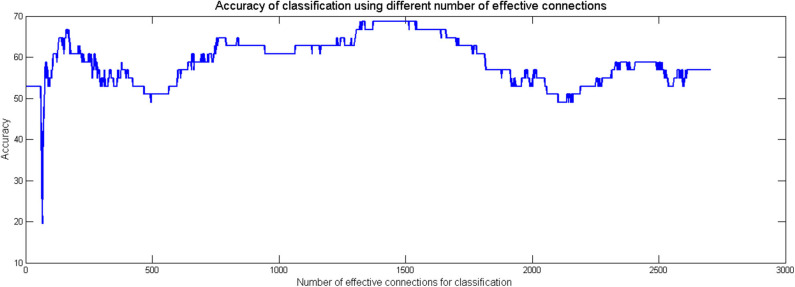
The relationship between classification accuracy and the number of effective connections used in the classification process. The effective connections were ranked according to F scores in descending order.